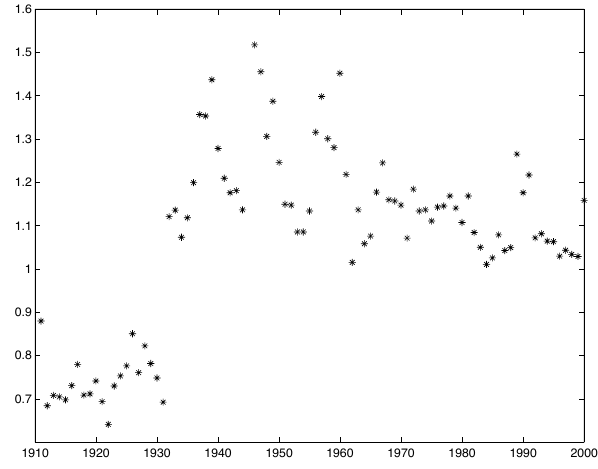
Fig. 1. Ratios of the annual IHV-raw averages between ESK and NGK. The ratio depicts a step-like increase from 1931 to 1932.